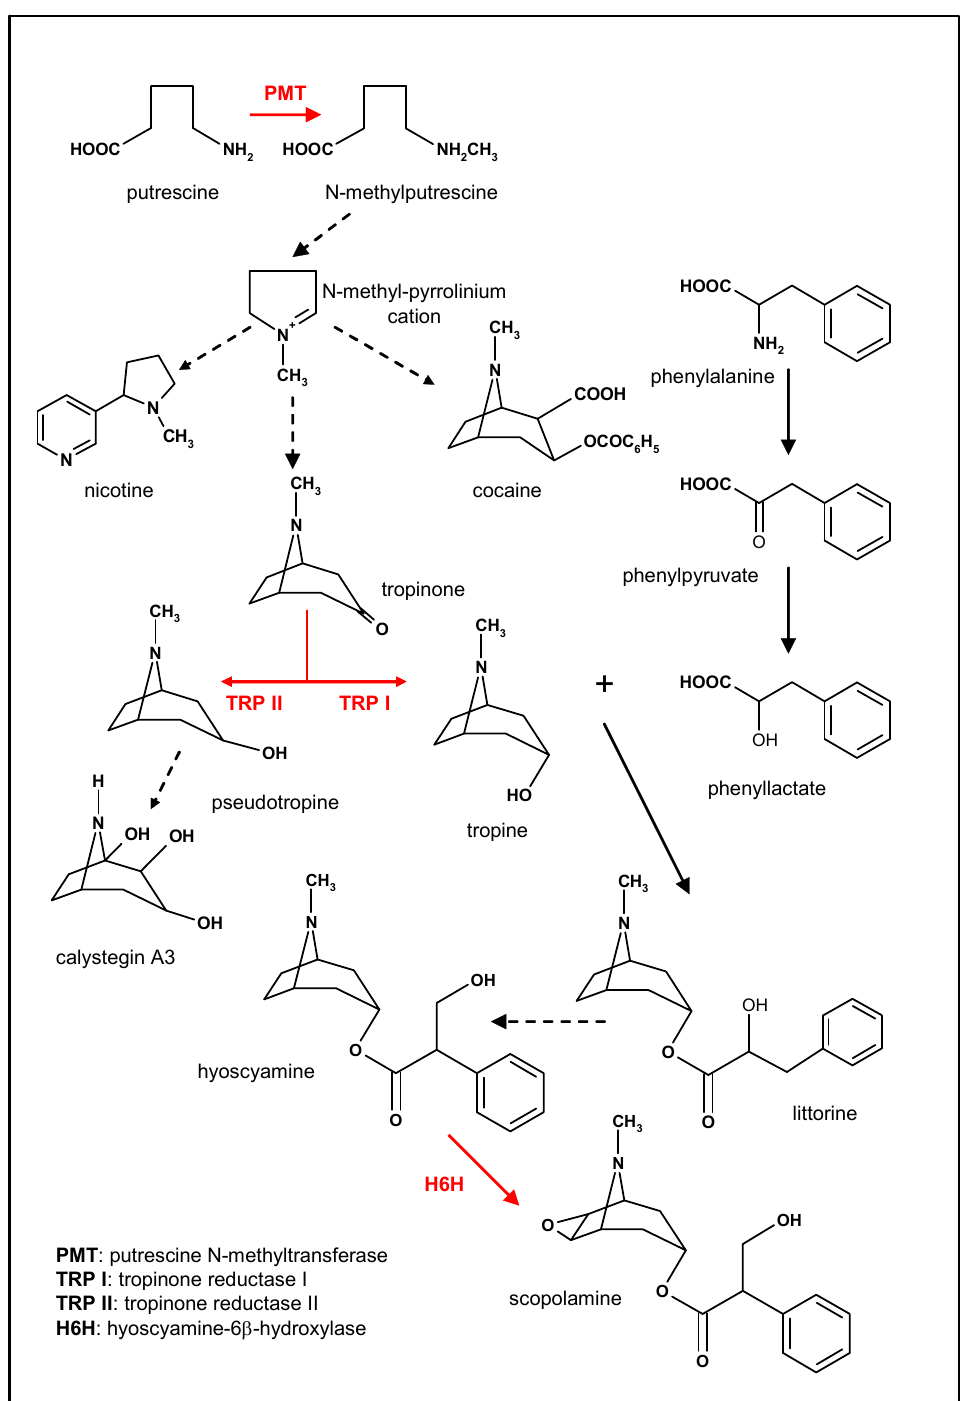
Figure 3. Overview of the most important steps in the scopolamine biosynthetic pathway. The enzymes overexpressed in scopolamine-producing hairy root cultures are in